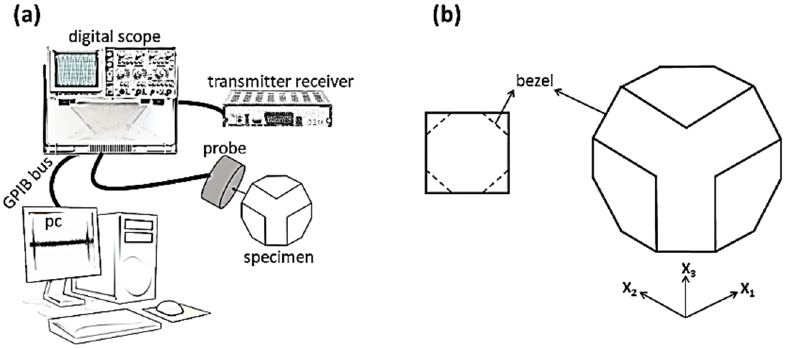
Figure 1. Schematic of ( a ) ultrasonic pulse instrument and ( b ) a sketch of prepared CaTiO 3 sample.